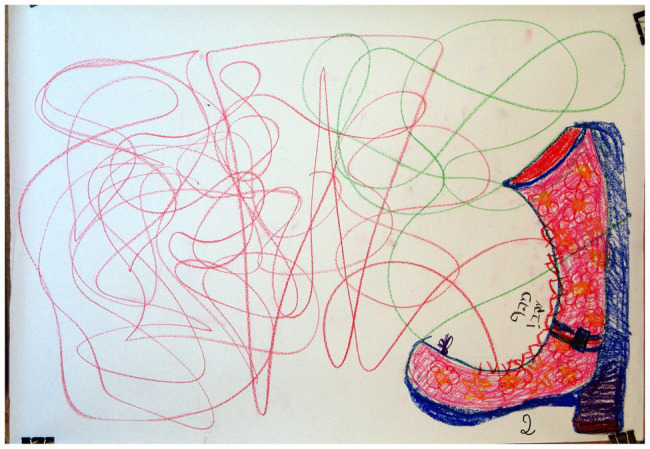
Image of an object.